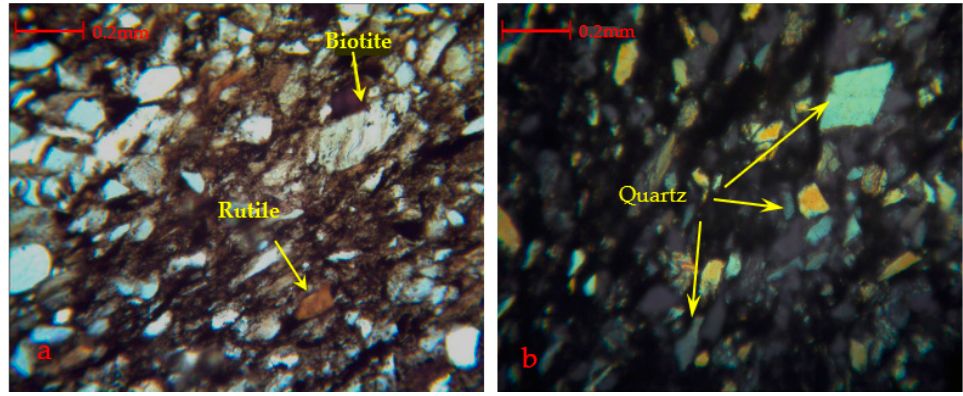
Figure 14. The mineral for rock slice of the roof of the No. 6 coal seam by polarizing microscope (10 ×